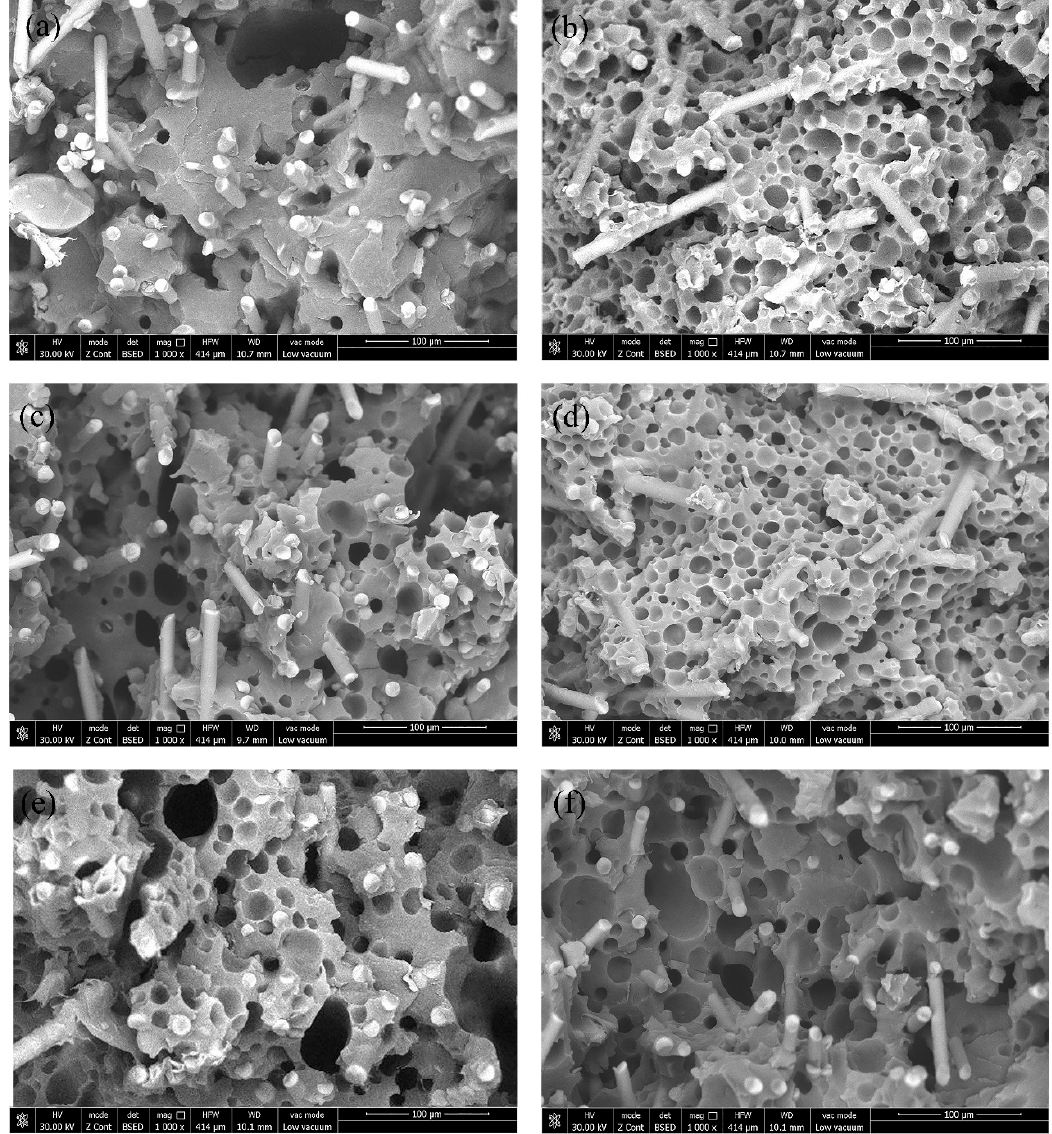
Figure 2. Microcellular structure of GF/PA foams at different factor levels: ( a ) The injection rate is 80–80% in the case of A3, ( b ) the injection rate is 50–80% in the case of A4, ( c ) the temperature is 250 °C in the case of B2, ( d ) the temperature is 270 °C in the case of B4, ( e ) the injection volume is 35.2 cm 3 in the case of C3, and ( f ) the injection volume is 40.2 cm 3 in the case of C5.